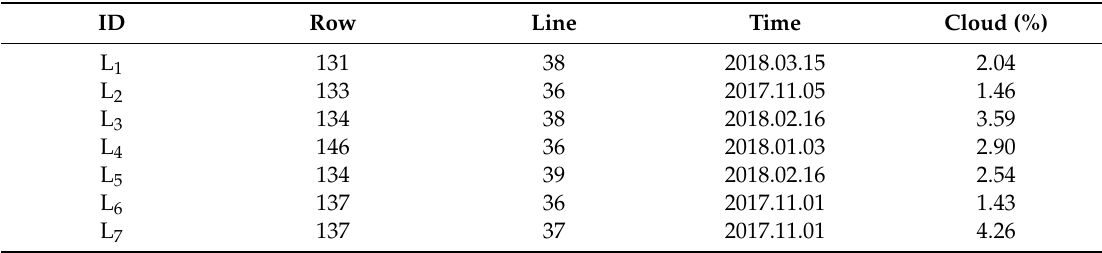
Table 1. Information on the Landsat 8 OLI images.